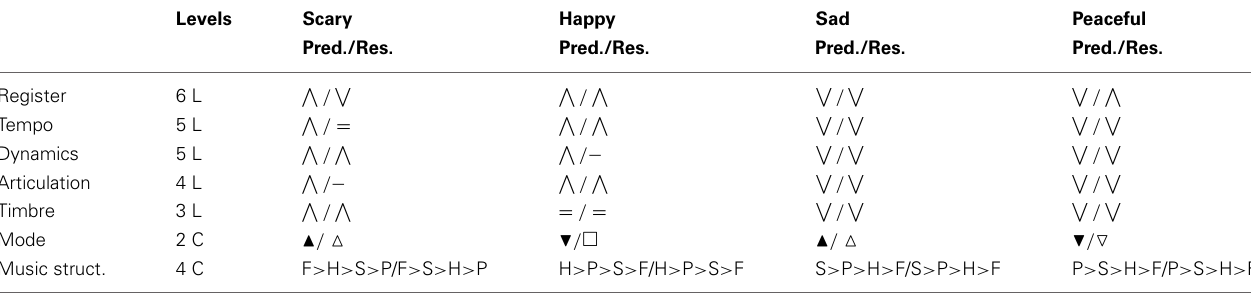
Table 3 | Theoretical prediction and results for each cue and emotion. Levels Scary Happy Sad Peaceful Pred./Res. Pred./Res. Pred./Res.